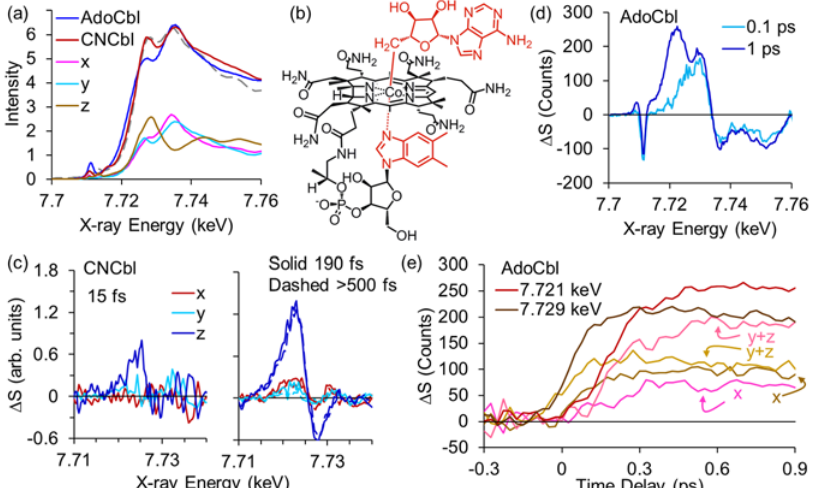
Fig. 1. (a) Experimental XANES spectrum of AdoCbl and CNCbl along with the simulated spectrum of CNCbl (gray dashed line) [5]. The individual x , y , and z contributions to the simulated spectrum are also plotted. (b) The structure for AdoCbl. CNCbl has a − C ≡ N group as the upper axial ligand. (c) The x , y , and z contributions to the XANES difference spectrum of CNCbl at three key time delays [3]. (d) The isotropic XANES difference spectrum following excitation of AdoCbl in water at 540 nm. (e) Time evolution of the XANES difference at the two peaks observed in